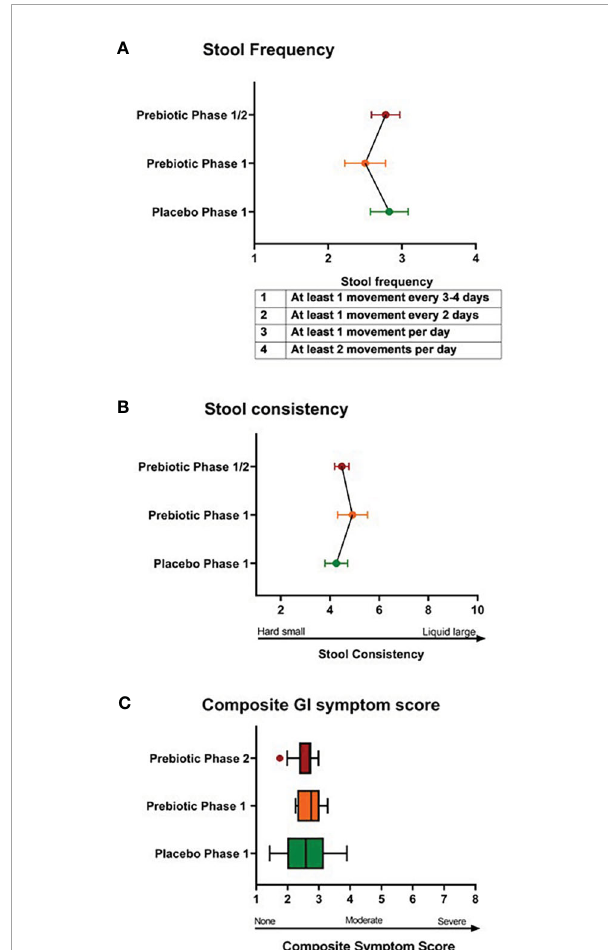
FIGURE 1 Comparison of stool frequency, consistency, and composite gastrointestinal symptoms. There were no differences in (A) stool frequency, (B) stool consistency, (C) composite gastrointestinal (GI) symptoms score between Phase 1 metformin/placebo green) vs. Phase 1 metformin/prebiotic (orange) vs. Phase 2 metformin/ prebiotic (red). Comparisons between groups were made by linear mixed models, adjusting for